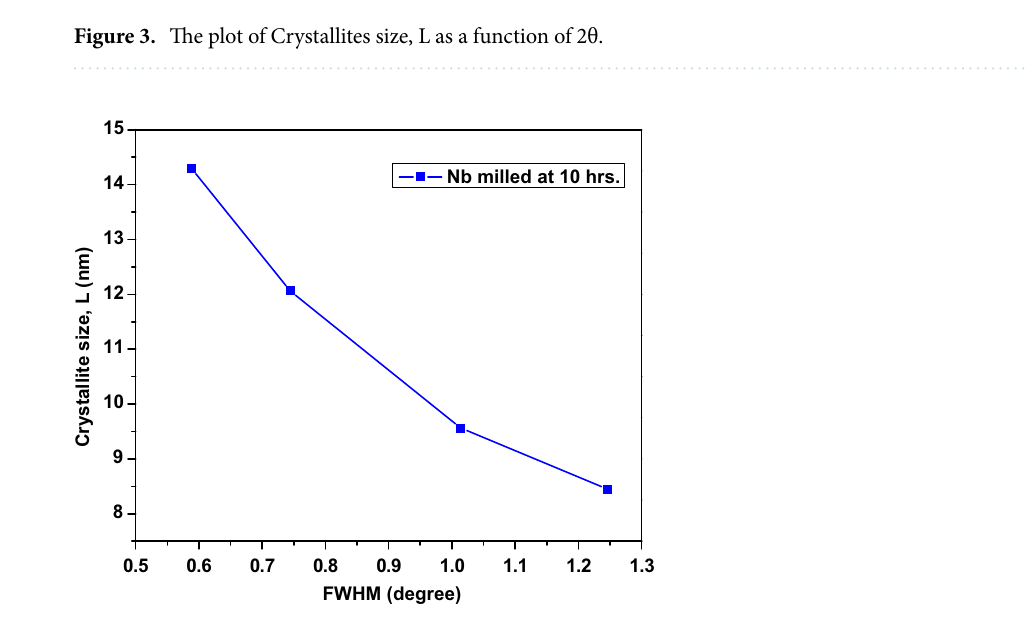
Figure 4. Plot of the crystallite size, L as a function of the FWHM of the peak